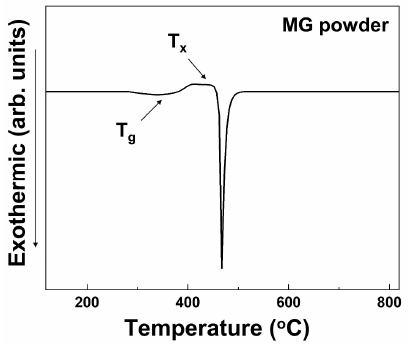
Figure 2. DSC curve of ZrAlCuMo MG powder used in target manufacture.